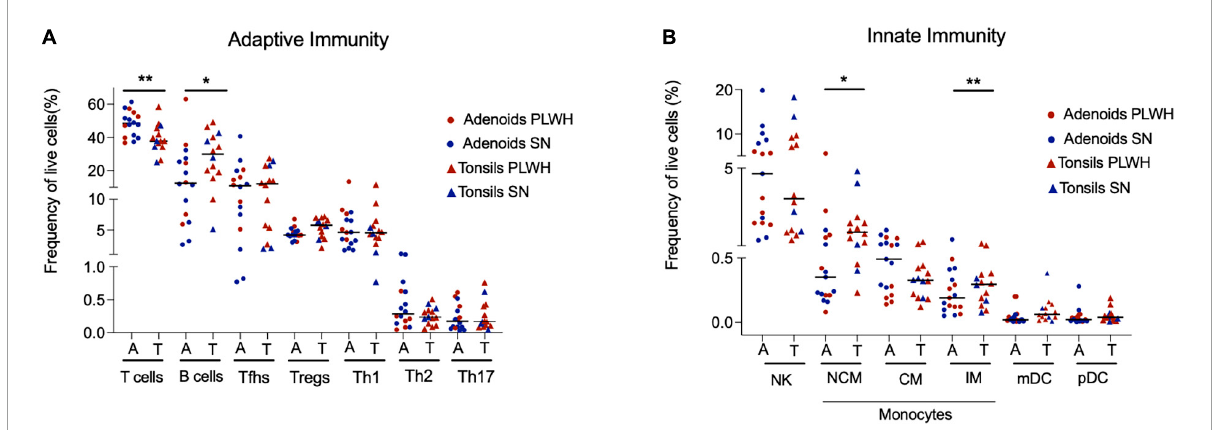
FIGURE2 Adenoids and tonsils have similar frequency of adaptive and innate immune cells. Adenoids and tonsils were obtained from PLWH and SN. The frequency (%) of adaptive and innate immunity cells were assessed by flow cytometry. (A) The frequencies (%) of T cells (CD3+), B cells (CD19+), and CD4+ T cells subpopulations: Tfhs (CD3+CD4+CD45RO+CXCR5+), Tregs (CD3+CD4+CD45RO+CD25+FOXP3+), Th1 (CD3+CD4+CD45RO+T-bet+), Th2 (CD3+CD4+CD45RO+CRTH2+), and Th17 (CD3+CD4+CD45RO+RORgt+) are shown. (B) The frequencies (%) of NK cells (CD56+), macrophages (classical CD14- CD16+, non-classical CD14+ CD16- and inflammatory CD14+ CD16+ HLADR-) and dendritic cells (myeloid dendritic cells CD123- CD11c+ and plasmacytoid dendritic cells CD123+ CD11c-) are shown. Scatter plots were used to present the data. The median is shown by a horizontal line. Each symbol represents one individual. Red triangle: PLWH tonsils, red circle: PLWH adenoids, blue triangle: SN tonsils, and blue circle: SN adenoids. Data was compared using the Wilcoxon Rank Sum test. Only p values < 0.05 are shown in the graphs. * p < 0.01; ** p < 0.001. %, frequency; CM, classical macrophages; CRTH2, chemoattractant receptor-homologous molecule expressed on TH2 cells; FOXP3, forkhead box P3 protein; HIV, human immunodeficiency virus; IM, inflammatory macrophages; mDC, myeloid dendritic cells; pDC, plasmacytoid dendritic cells; PLWH, people living with HIV; NCM, non-classical macrophages; NK, natural killer; RORgt, retinoic acid-related orphan receptor-gammat; SN, seronegative; Tfhs, T follicular helper cells; Th, T helper; and Tregs, T